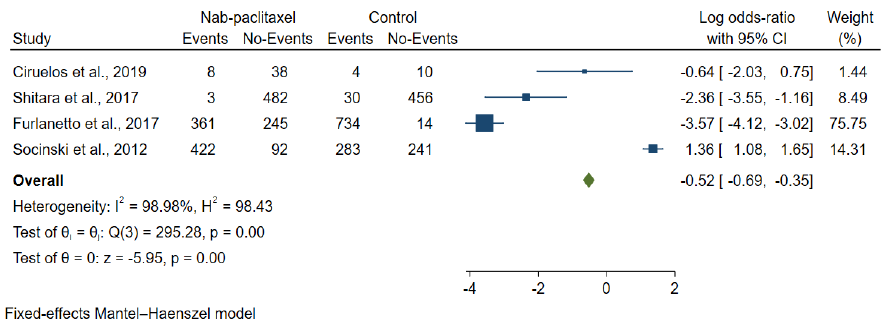
Fig. 3. The forest plot showed the odds ratio of treatment delay due to adverse events.